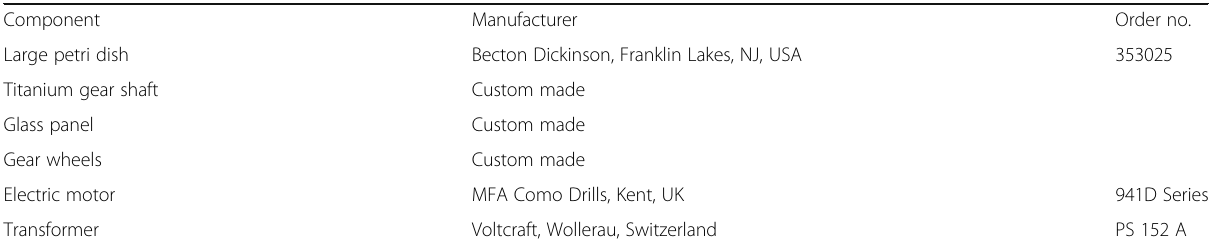
Table 1 Listing of the single components of the flow chamber together with manufacturers ’ data Component